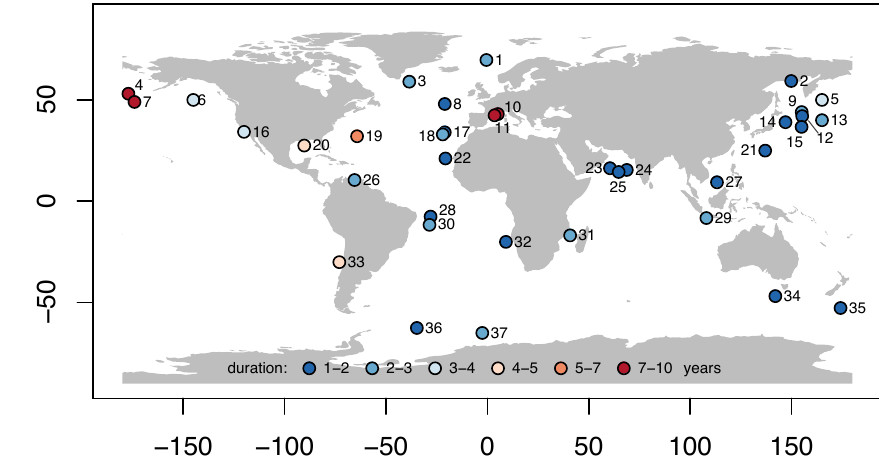
Figure 1. Distribution and duration of sediment trap time series used in this study. Site numbers refer to Table